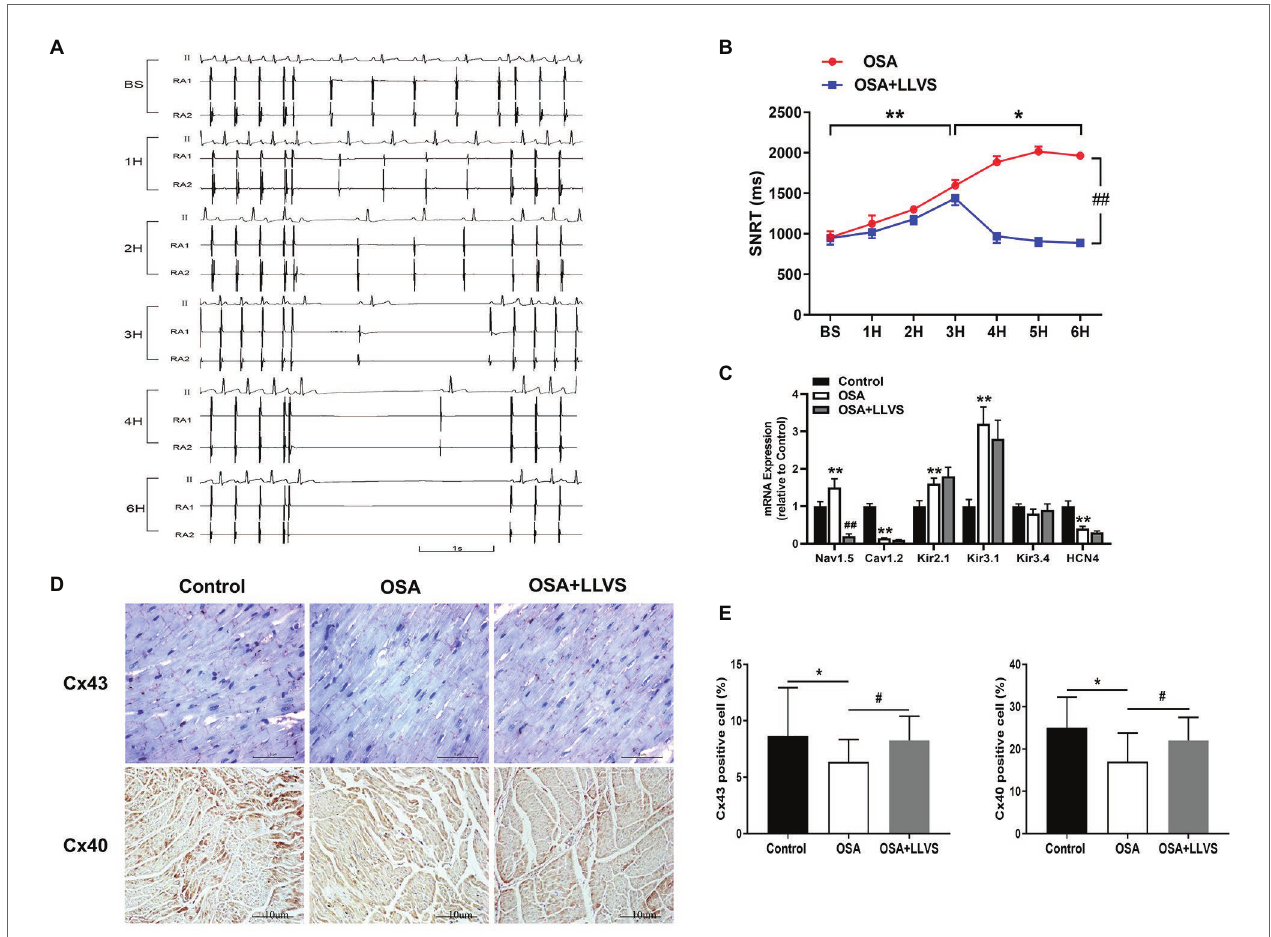
FIGURE 3 | (A) Representative examples of SNRT in the OSA group at baseline, the 1st hour, the 2nd hour, the 3rd hour, the 4th hour, and the 6th hour. (B) Changes in SNRT between the OSA and OSA+LLVS groups at each hour. (C) Changes in ion channels via gene expression level among the three groups. (D) Representative immunohistochemical staining of Cx 40 and Cx 43 on the LA among the three groups. (E) Quantitative analysis of Cx 43 and Cx 40-positive cells in the LA of each group. * p < 0.05, ** p < 0.01 vs. the control group; # p < 0.05, ## p < 0.01 vs. the OSA+LLVS group; SNRT, sinoatrial node recovery time; Cx 43, connexin 43; Cx40, connexin 40; H,